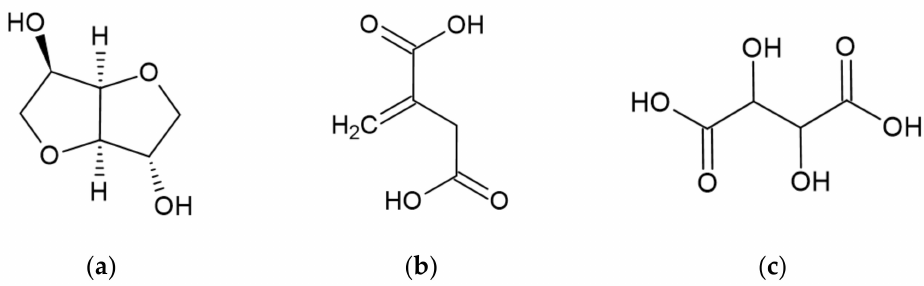
Figure 5. Structures of: ( a ) isosorbide [21]; ( b ) itaconic acid [22]; ( c ) tartaric acid